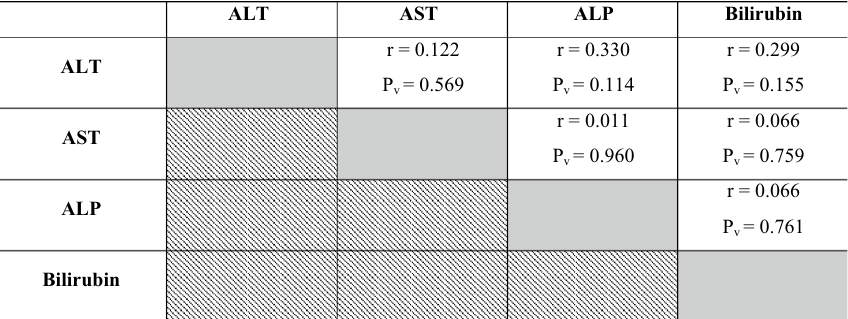
Table 4. Pearson correlation coefficient between hepatic biomarkers in investigated Dabb lizards. ALT Alanine aminotransferase, AST Aspartate aminotransferase, ALP Alkaline phosphatase, R Correlation. P v : P value: